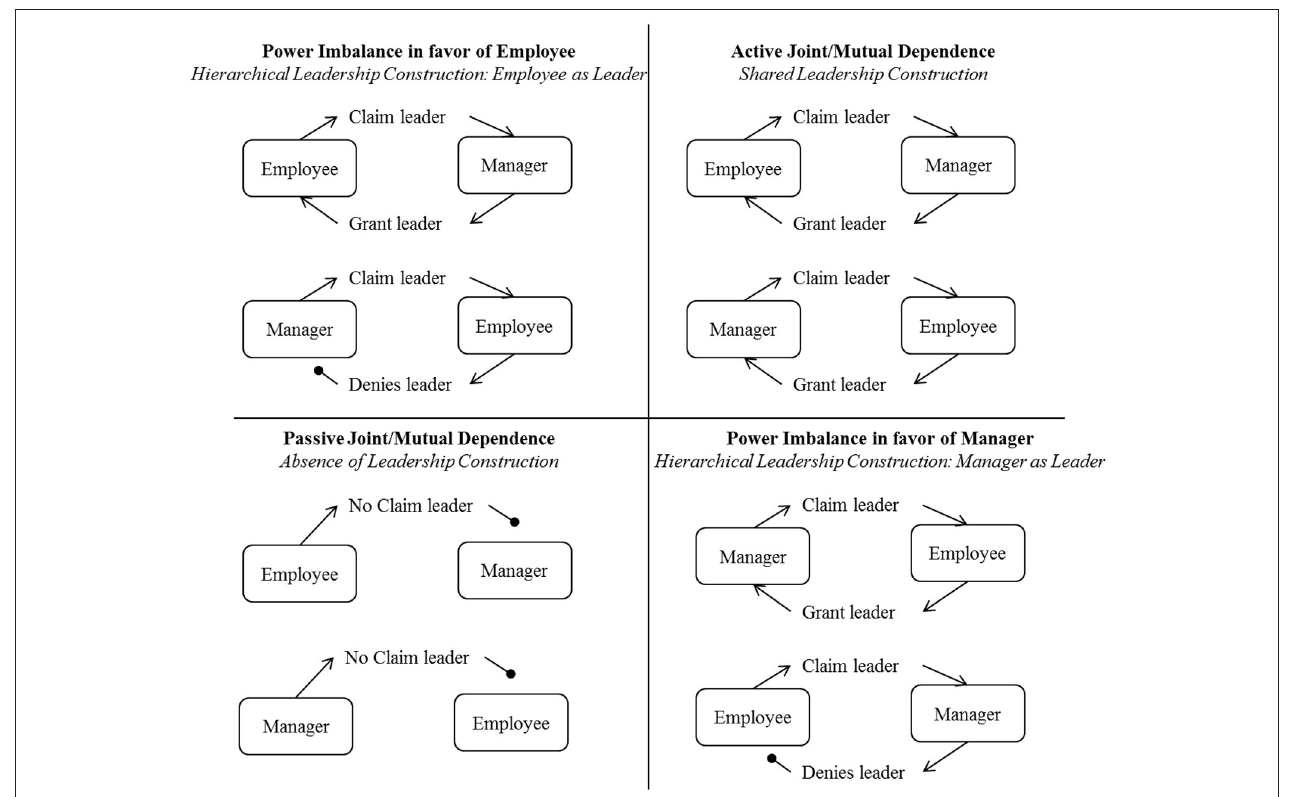
FIGURE 3 | Leadership construction in dependence